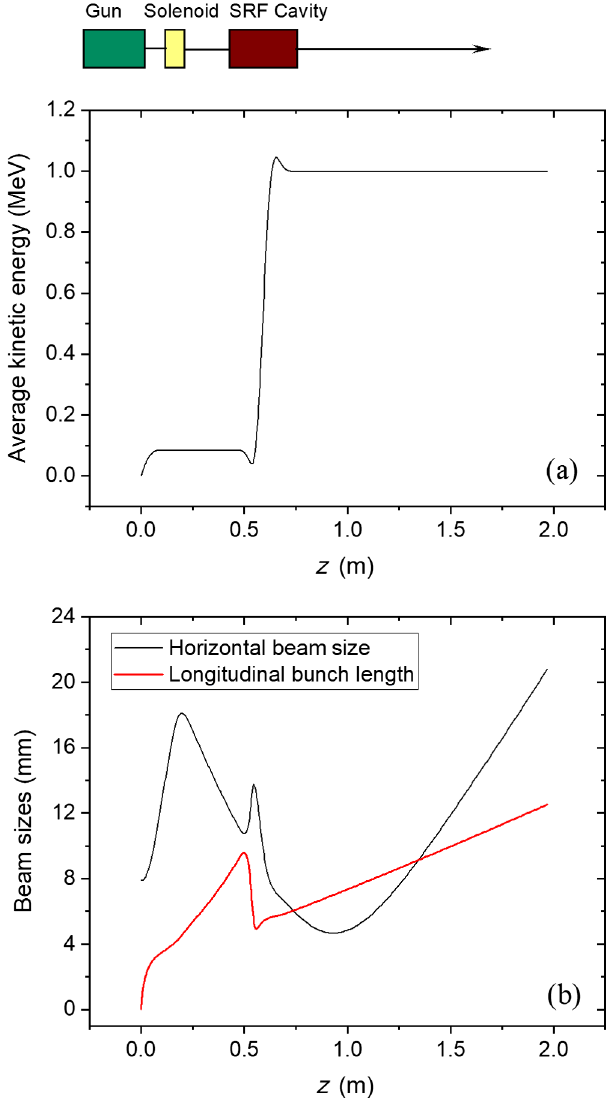
FIG. 1. Average beam energy (a), transverse rms beam size and longitudinal rms bunch length (b) along the beam axis for a 915 MHz, 1 MeV, 1 A linac obtained from a simulation with GPT . The schematic layout on top is not to